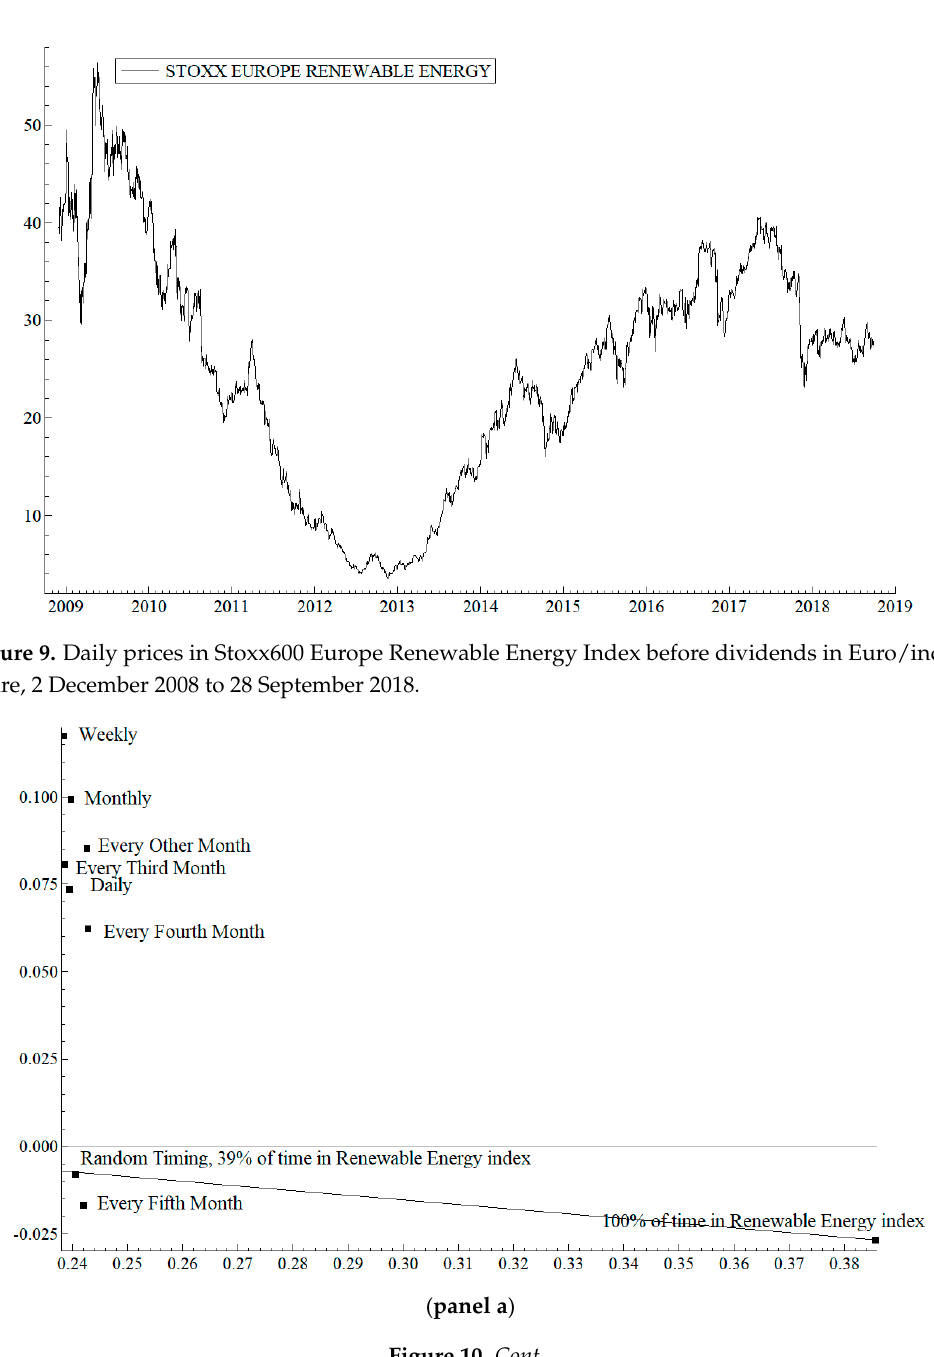
( panel a ) Figure 10. Cont ( panel a )